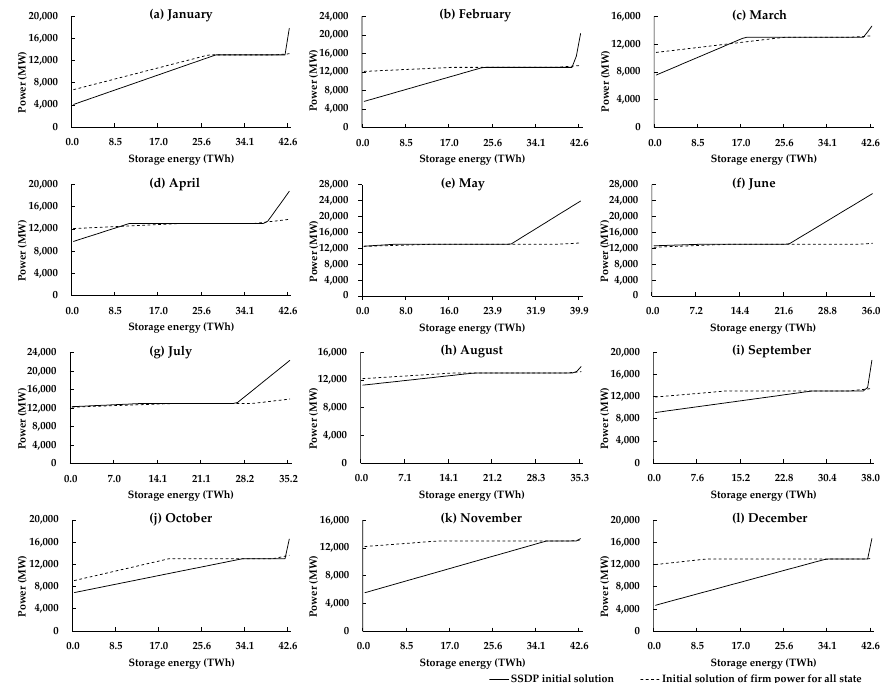
Figure 6. The result of operation rules obtained by these two methods: ( a ) January, ( b ) February, ( c ) March, ( d ) April, ( e ) May, ( f ) June, ( g ) July, ( h ) August, ( i ) September, ( j ) October, ( k ) November, ( l ) December. The difference between the objective function values using these two operation rules is mainly due to the shortage extent in some dry season months. Figure 7 shows an exam- ple of simulation difference in several years. Using rule 1, the periods of firm power short- age are shorter than using rule 2, and the shortage extent is larger. It is because the power decreasing regions of rule 2 are much larger than rule 1. Therefore, using rule 2, the hy- dropower system reduces power generation earlier than using rule 1, and the shortage is allocated to more periods than when using rule 1. The penalty function of firm power is